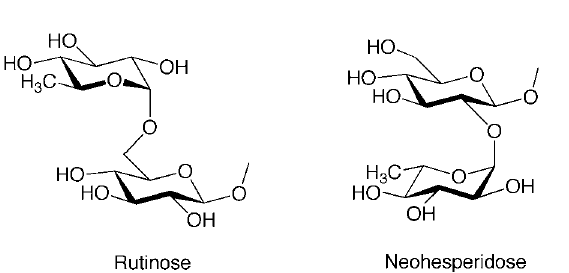
Figure 2. Rutinose and